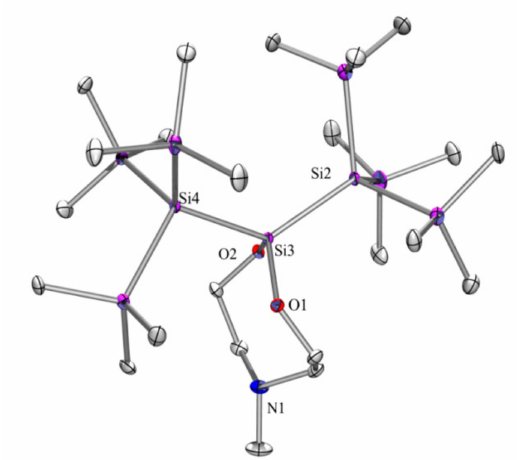
Figure 2. Molecular structure of 8 (thermal ellipsoid plot drawn at the 30% probability level). All hydrogen atoms are omitted for clarity (bond lengths in Å, angles in deg). Si(3)-O(1) 1.652(2), Si(3)-O(2) 1.660(2), Si(3)-Si(4) 2.3811(12), Si(3)-Si(2) 2.3881(13), Si(2)-Si(1) 2.3542(14), Si(1)-C(7)